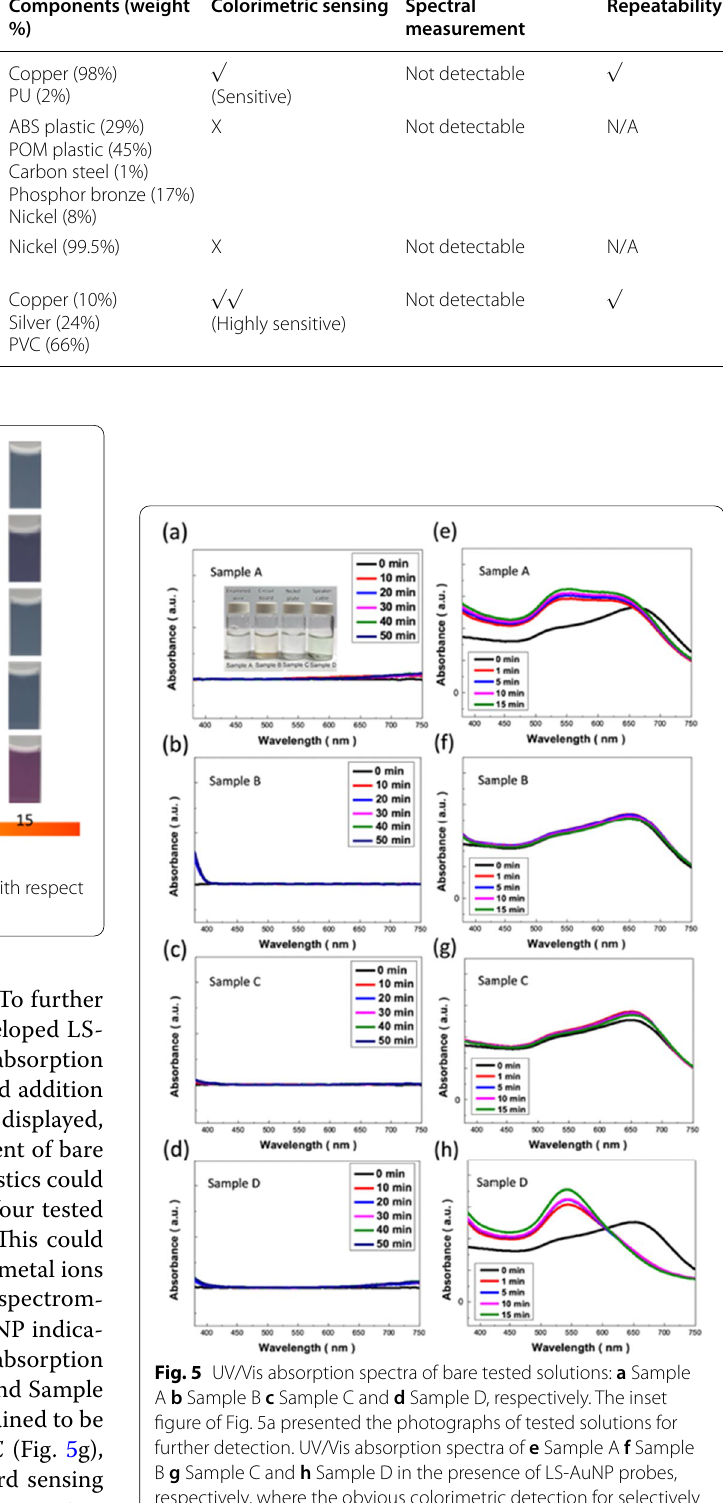
Table 1 Detailed information and correlated sensing capabilities of four practical samples Sample Electronic materials (product name)